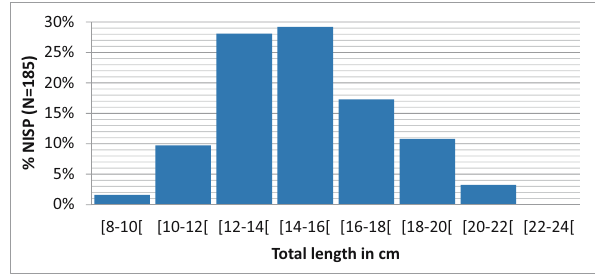
Figure 5: Reconstructed size distribution of cyprinids from layer 3 ( N = 185 vertebrae ) .